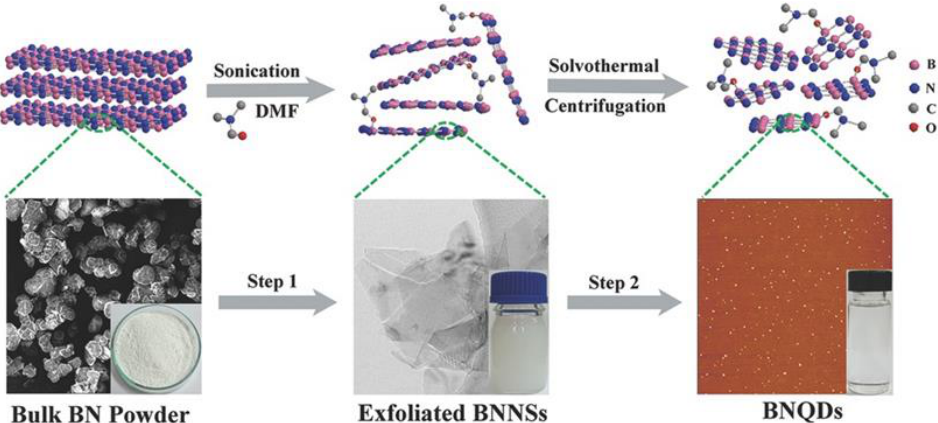
Figure 4. Schematic illustration of the BNQD synthesis procedure, including the sonication-assisted liquid exfoliation of h-BN bulk powder to synthesize BN nanosheets and solvothermal treatment to fabricate BNQDs [36]. Reproduced with permission. Copyright 2017 WILEY-VCH Verlag GmbH & Co. kGaA (Weinheim, Germany).